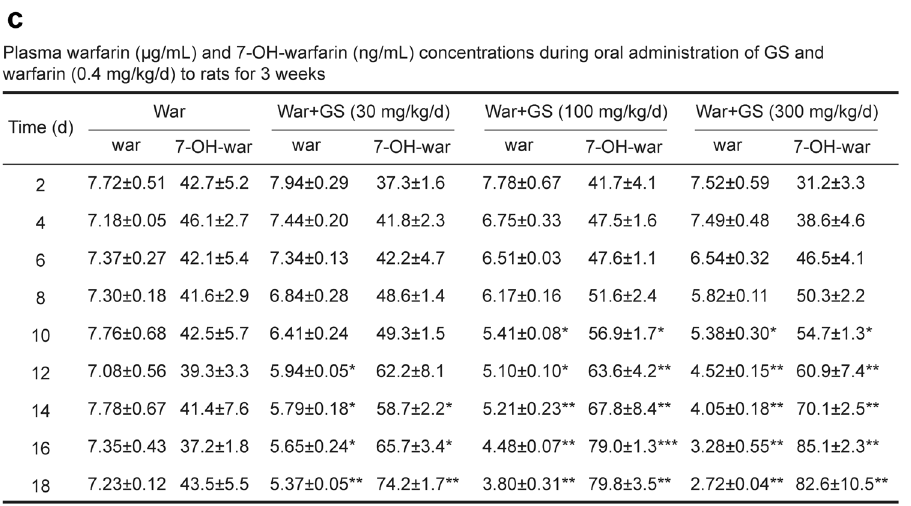
Figure 5. GS dose- and time-dependent intervention on plasma warfarin concentrations. ( a ) One-week warfarin (0.4 mg/kg/d) plus three-week warfarin co-administered with GS (30, 100, 300 mg/kg/day) for 1, 2, or 3 weeks decreased plasma warfarin (in µ g/mL) in a dose- and time-dependent manner; ( b ) meanwhile, the regimen increased plasmawarfarin metabolite 7-OH warfarin (in ng/mL); ( c ) quantitative data showed the concomitant decrease in plasma warfarin and increase in 7-OH warfarin. The blood was withdrawn from rat tail vein for UPLC-MS/MS analysis every other day. * P < 0.05; ** P < 0.01, statistically significant differences between warfarin alone and warfarin plus GS (n = 10 per group), unless otherwise